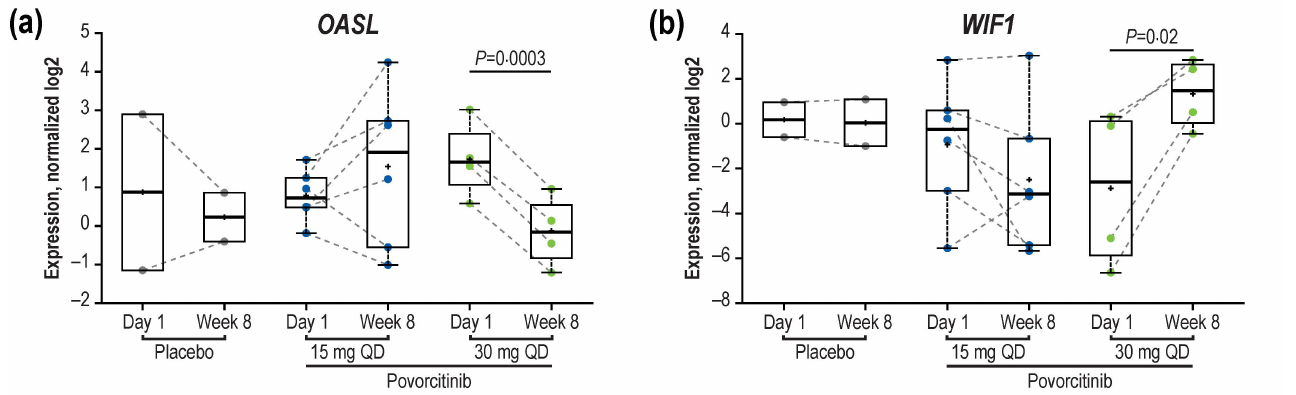
Figure 4. OASL and WIF1 gene expression in HS lesional skin biopsies over 8 weeks of treatment. ( a ) OASL, ( b ) WIF1. HS, hidradenitis suppurativa; QD, once